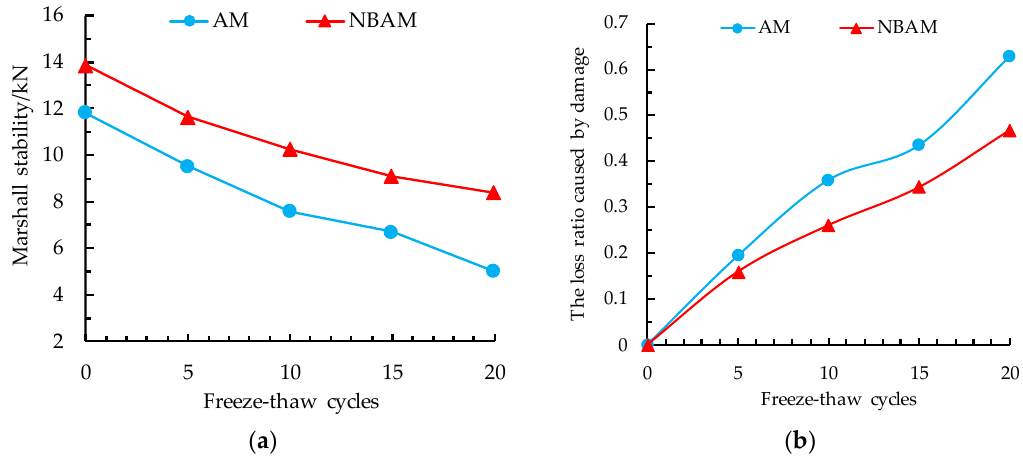
Figure 8. Stability changes: ( a ) Relationship between stability and freeze‒thaw cycles; ( b ) relationship between stability damage and freeze‒thaw cycles.